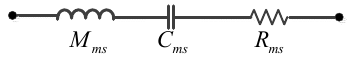
Figure 3. Equivalent circuit of electromagnetic part.